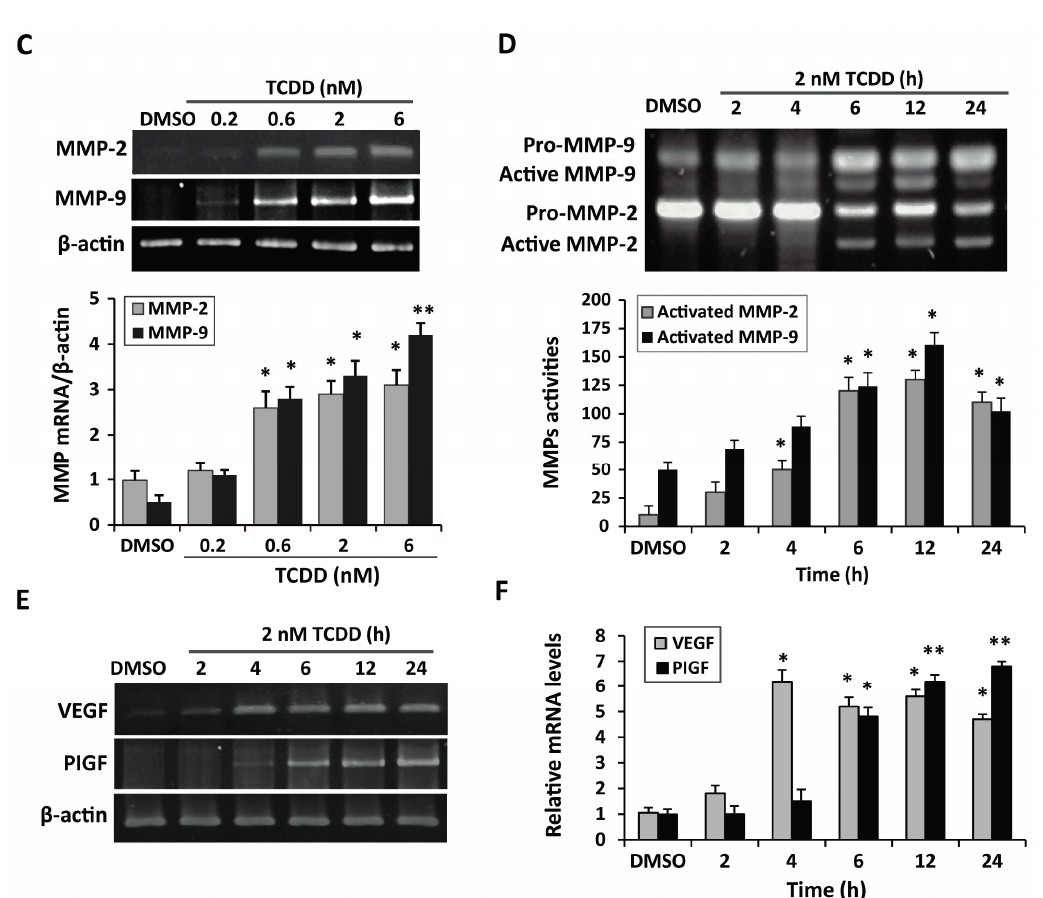
2.5. Inhibition of Peroxisome Proliferator-Activated Receptor γ (PPAR γ ) and PPAR γ Coactivator-1